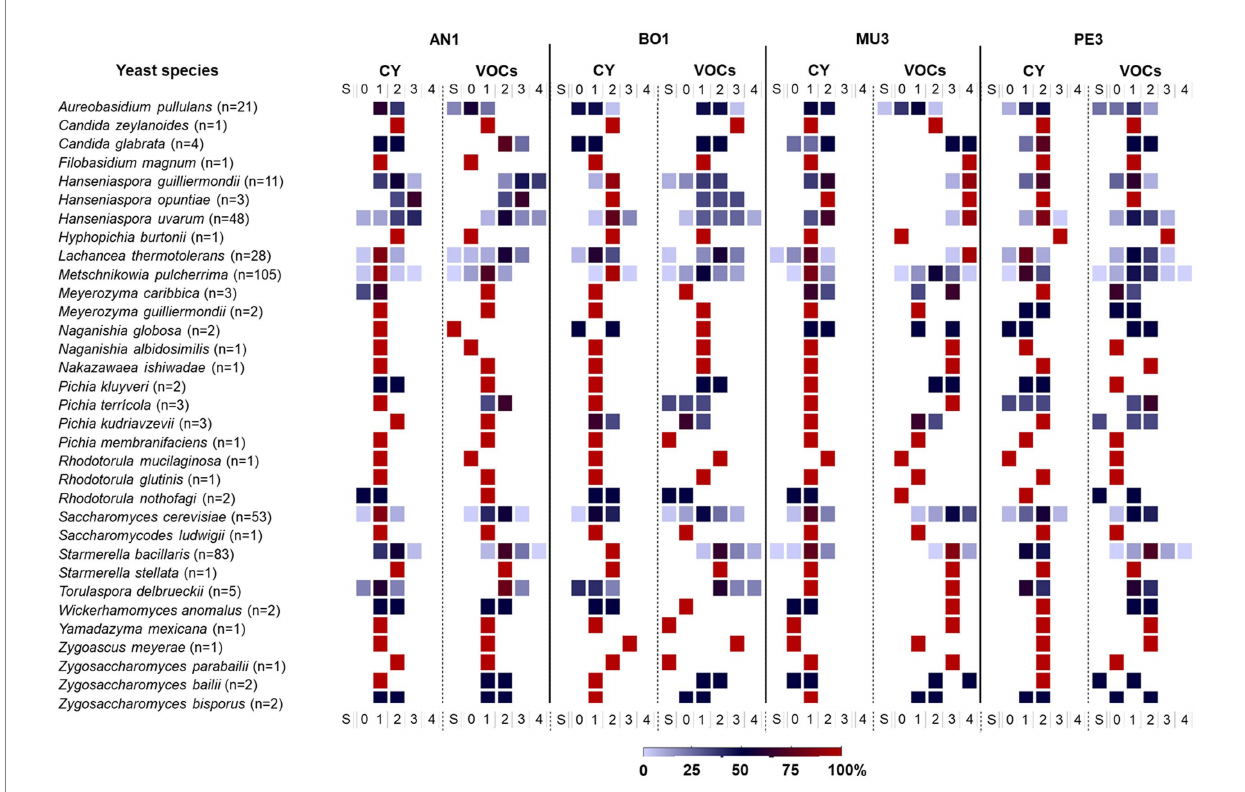
FIGURE 5 Frequency distribution of yeast strains for each species based on their antagonistic activity against the four mold targets. Classes of yeast strains were defined based on IAC values: class 0 (no effect: IAC < 5%), class 1 (weak effect: 5% ≤ IAC < 25%), class 2 (moderate effect: 25% ≤ IAC < 50%), class 3 (strong effect: 50% ≤ IAC < 75%) and class 4 (very strong effect: IAC ≥ 75%). Strains with stimulatory effect of mold growth were included in class S. The color gradient refers to the percentage of strains in each class. AN1 – Aspergillus niger ; BO1 – Botrytis cinerea ; MU3 – Mucor sp.; PE3 – Penicillium sp.; CY